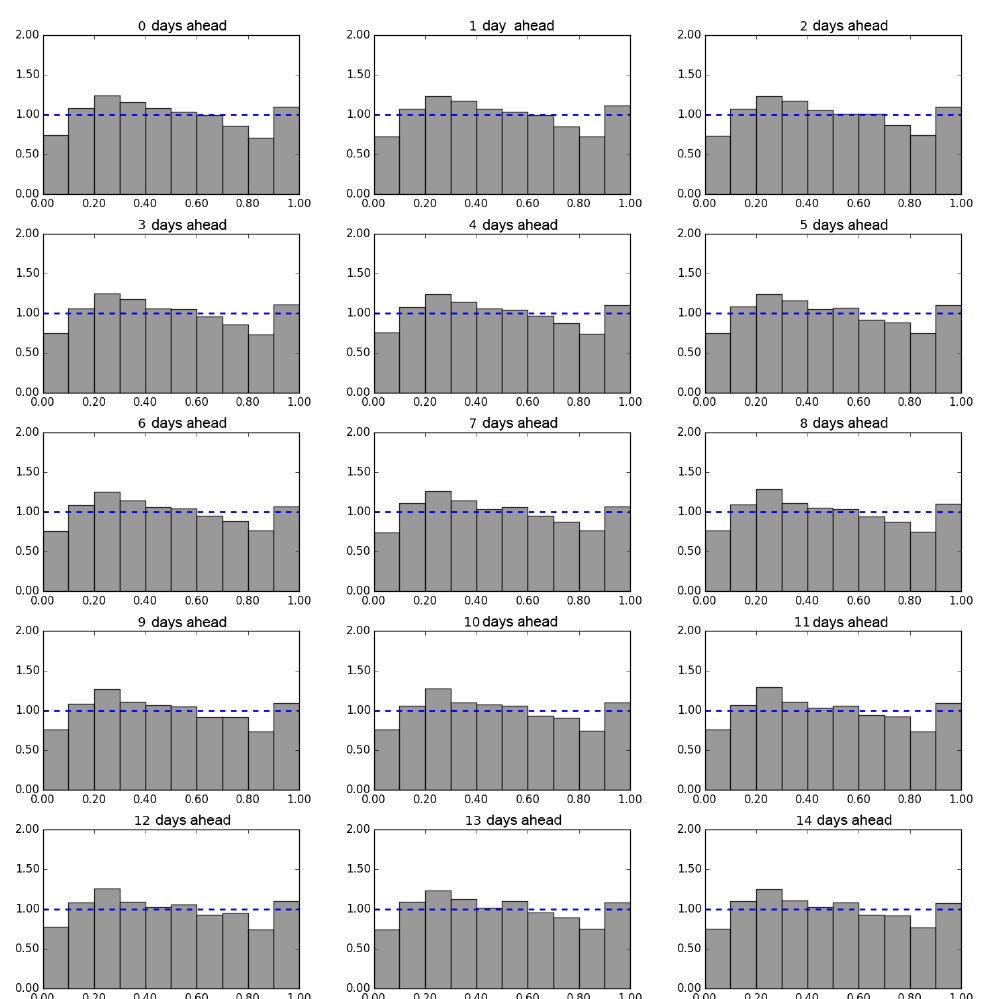
Figure 3. PIT histograms of seasonal streamflow forecasts for lead times ranging from 0 to 14 days (the x axis of the plot represents PIT value, and the y axis normalised frequency). The blue dotted line marks the expected